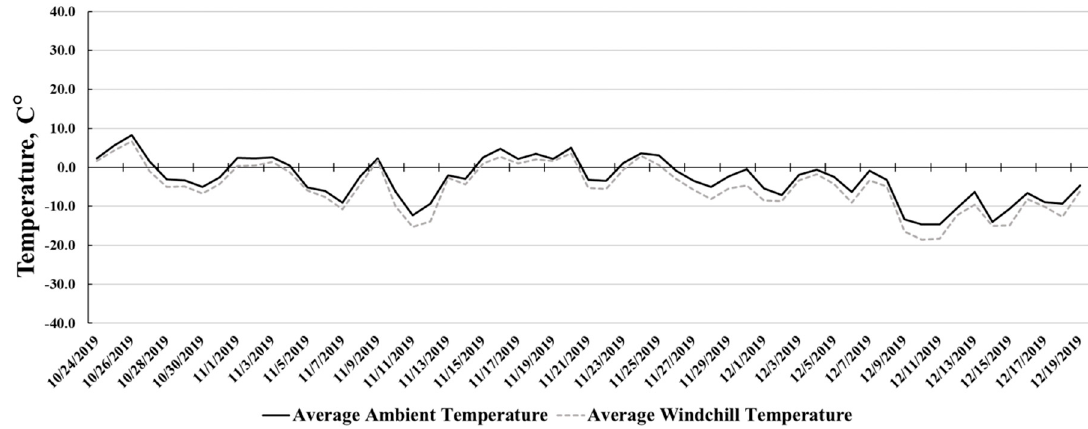
Figure 2. Experiment 2: Cumulative average ambient temperature (°C) and average wind chill temperature (°C) during the study (24 October 2019 to 19 December 2019).